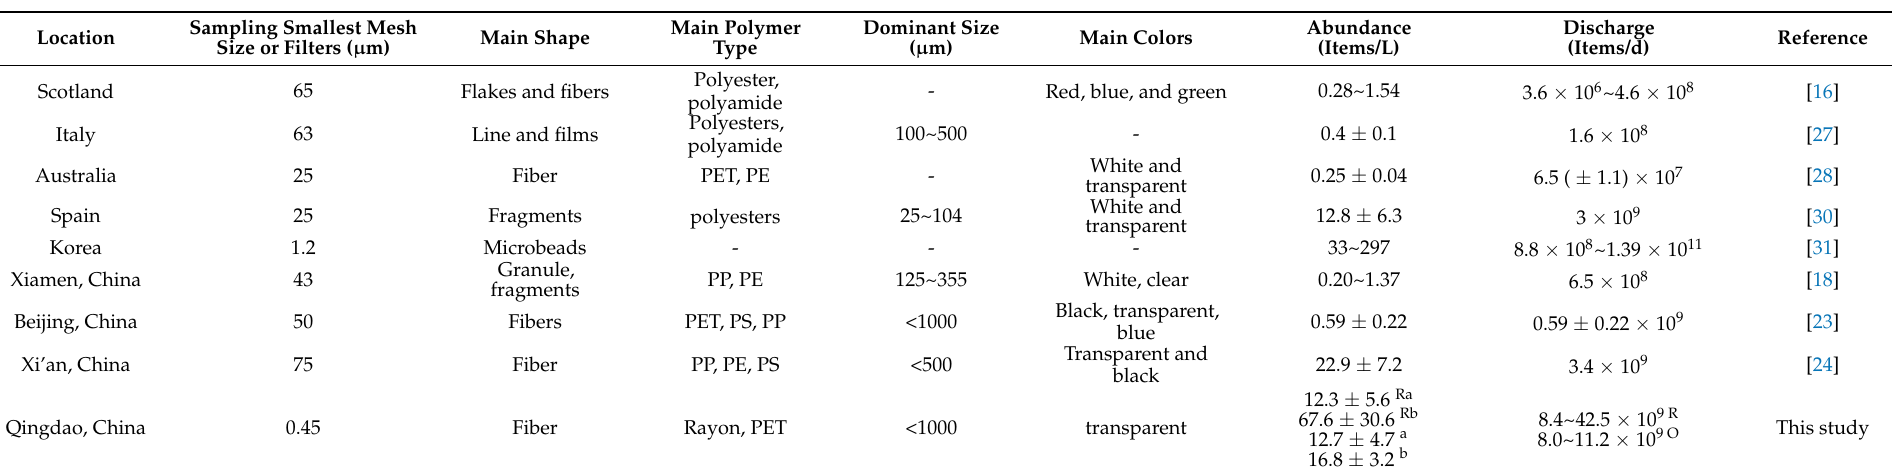
Table 2. Comparison of characteristics, abundance, and emission of MPs in the effluent from WWTPs in different